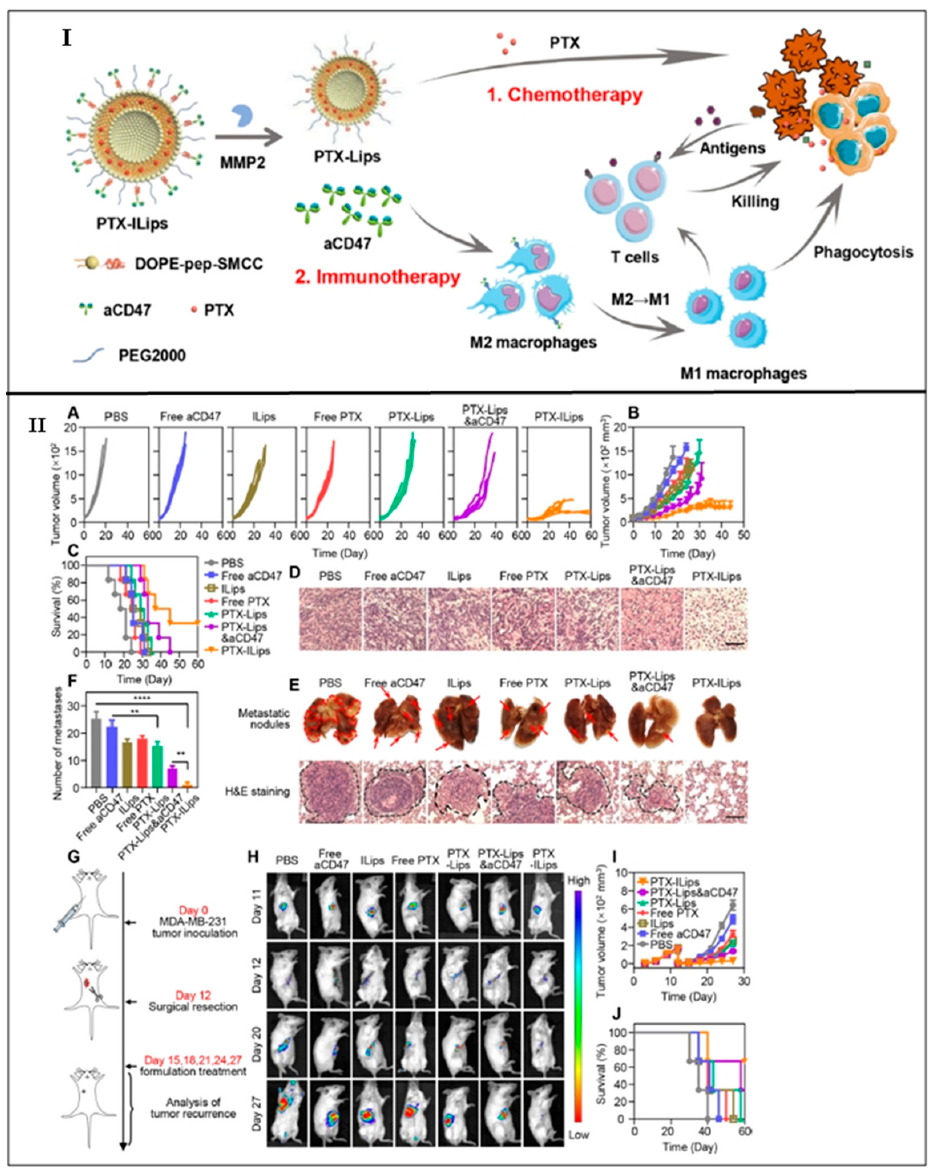
Figure 3. ( I ) An illustration displaying the construction of PTX-ILips and the release of PTX and aCD47 from the liposome for effective chemotherapy and immunotherapy respectively against TNBC. ( II ) Anticancer efficacy study and recurrence inhibition study in vivo: ( A ) Individual tumor growth curves in different groups. ( B ) Tumor growth kinetics of MDA-MB-231 tumors in mice treated with different formulations. ( C ) Survival rates of animals in various groups. ( D ) H&E staining of tumor slices collected from mice after the treatment of 21 days. Scale bar = 100 μ m. ( E ) Photographs of lung metastatic nodules and histological assessment of lung metastatic nodules via H&E staining. Scale bar = 100 μ m. ( F ) Numbers of lung metastatic nodules from each group. ( G ) Schematic illustration of the establishment of tumor recurrence model and therapy with different formulations. ( H ) Representative IVIS images of MDA-MB-231 tumor-bearing mice in each group. ( I ) Tumor volume growth curves after tumor implantation, subsequent surgery, and therapy. ( J ) Survival of mice in different treatment groups. Data are displayed as the mean ± SD. ** p < 0.01; **** p < 0.0001 . Reprinted (adapted) with permission from [54]. Copyright (2021) American Chemical Society.